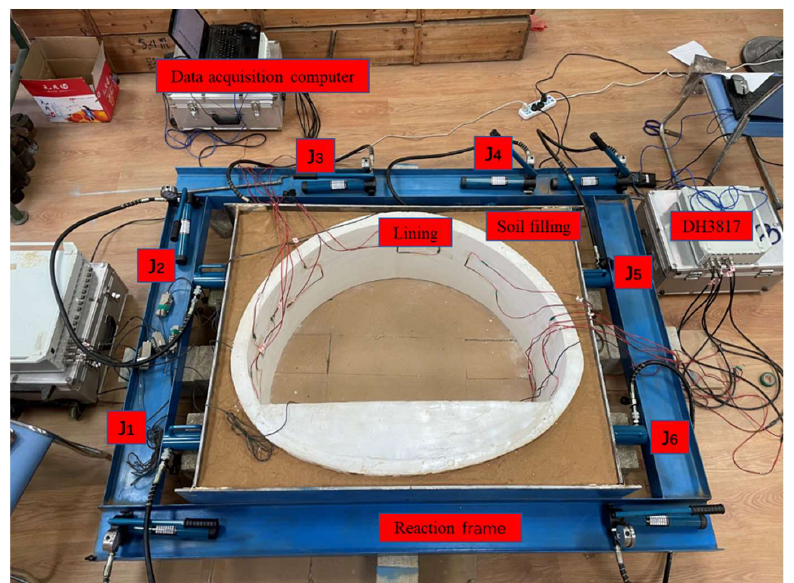
Figure 5. Self-made indoor similar model platform.